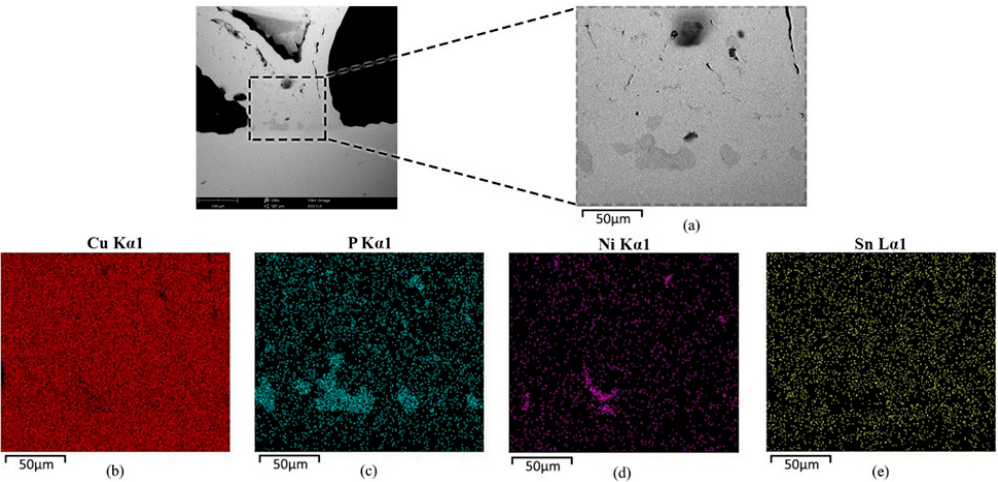
Figure 4. Map analysis of joint interface brazed at 680 °C for 10 min: ( a ) SEM micrograph of the base of the joint; and elemental analysis of ( b ) Cu, ( c ) P, ( d ) Ni, ( e ) Sn.